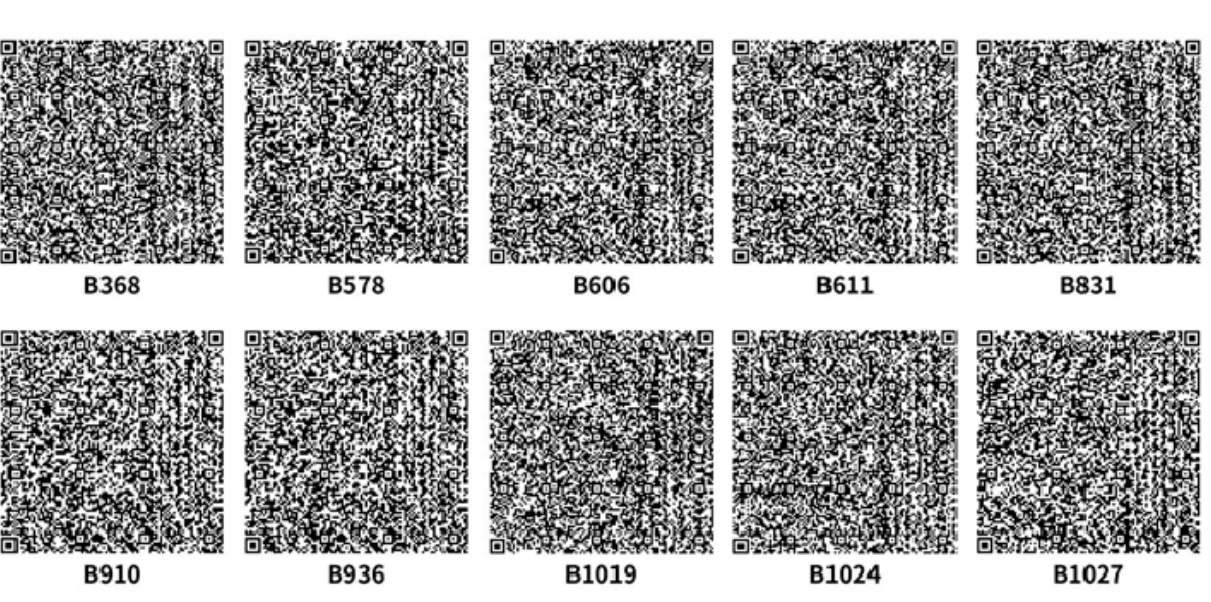
Figure 2. QR codes of the tested materials.